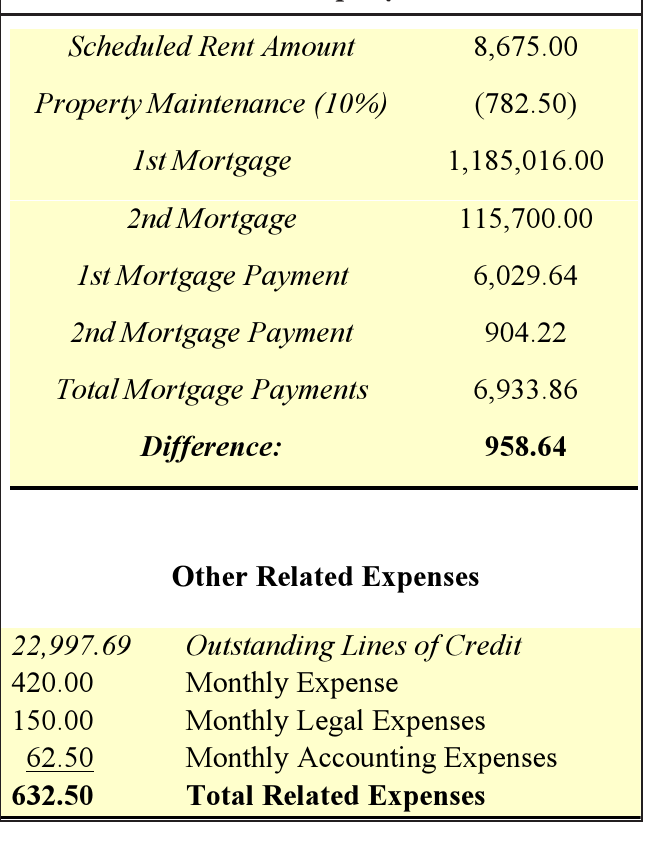
Table 2. Summary Financials of D&H Management LLC Portfolio—Property Cash